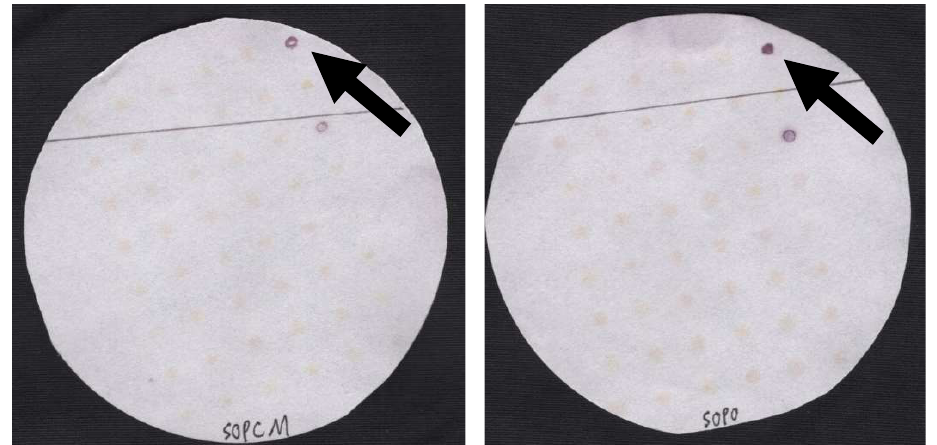
Two examples of these filters are illustrated in Figure 1.